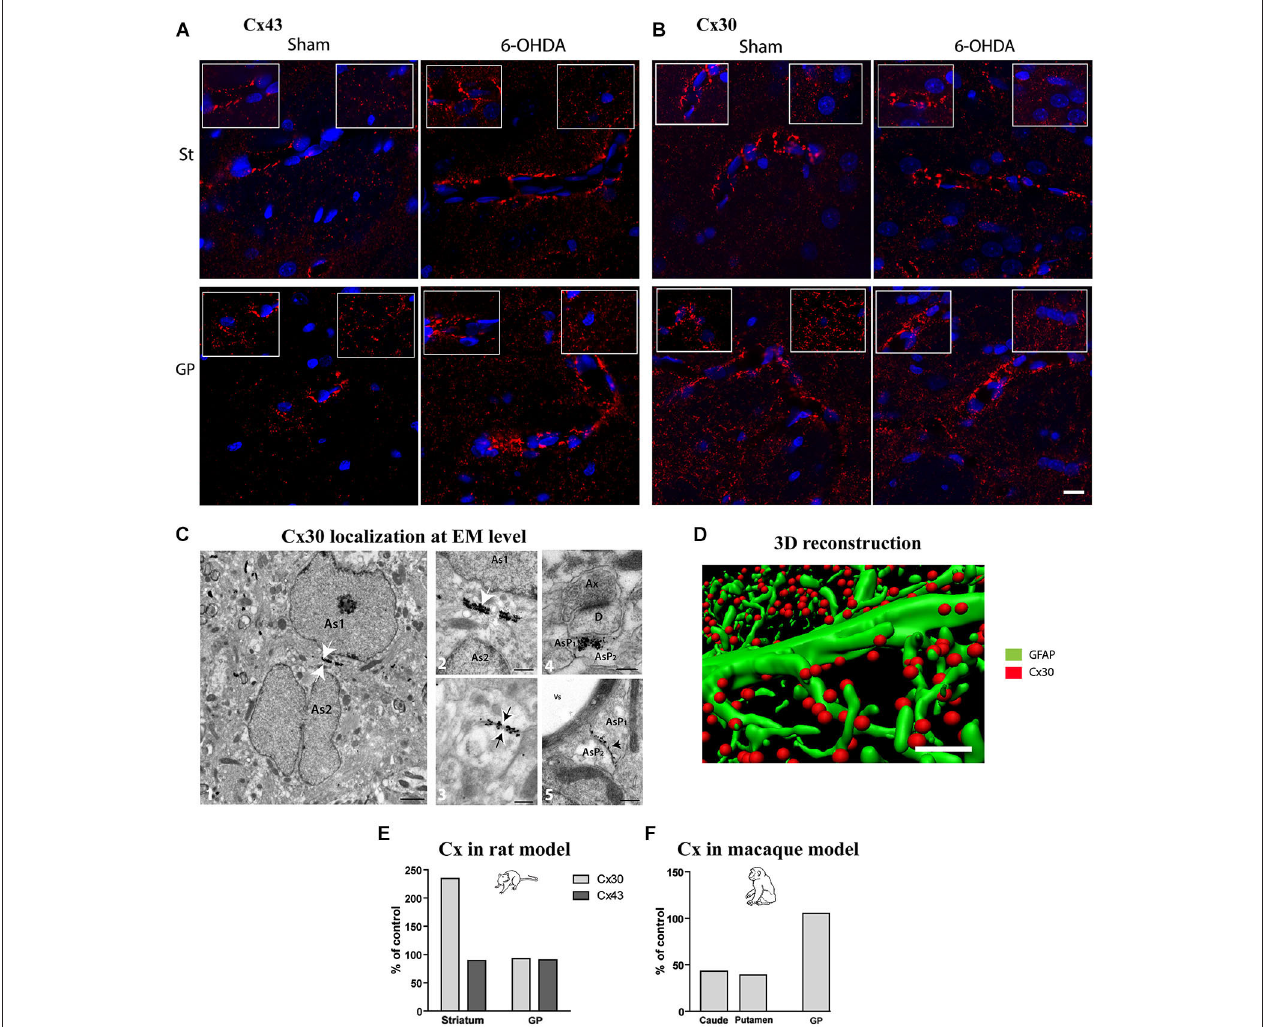
symmetrically labeled gap junction between two astrocytic processes (black arrow; AsP = astrocytic process) (scale bar = 0.5 µ m); 4-symmetrically labeled gap junction between two astrocytic processes close to asymmetrical synapse (scale bar = 0.5 µ m); 5-asymmetrical labeled gap junction between two astrocytic processes (scale bar = 0.5 µ m). (D) Illustration of quantification methodology of connexin based on double immunolabeling. GFAP immunostaining appears in green while Cx 30 immunostaining appears in red (scale bar = 2 µ m). (E) Connexin Cx30 and Cx43 quantification in the 6-OHDA rat and (F) in MPTP monkey models of PD expressed in percentage of levels measured in control